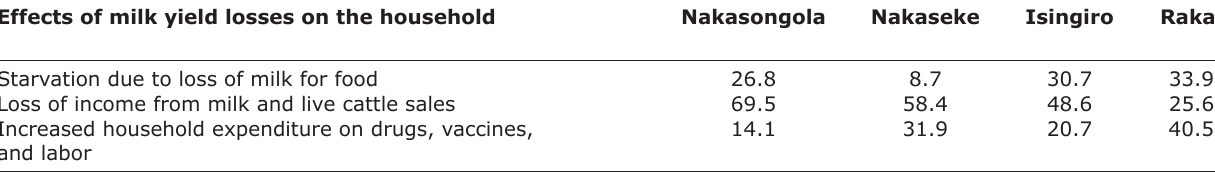
Increased household expenditure on drugs, vaccines, and labor